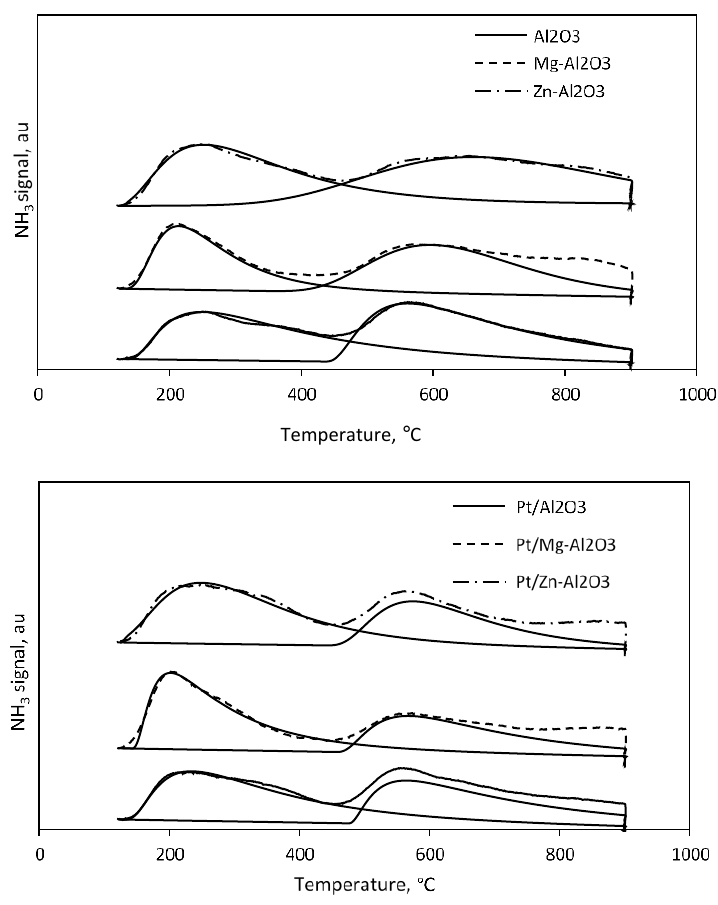
Figure 8. NH 3 -TPD profiles of Al 2 O 3 supports and Pt/Al 2 O 3 catalysts. Table 4. The acidity of supports and catalysts, determined by NH 3